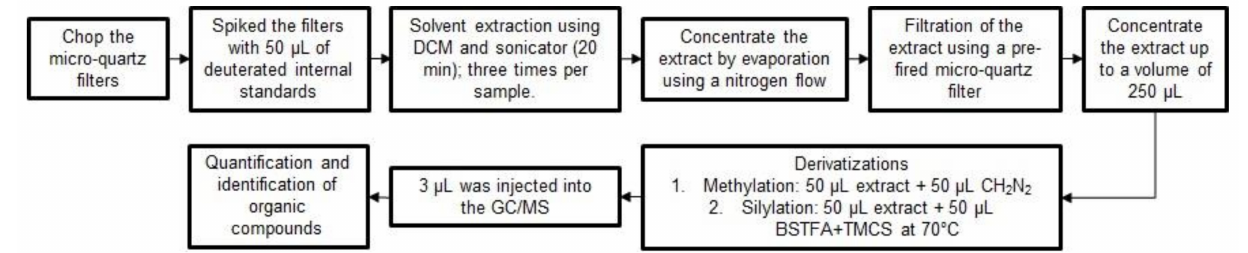
Figure 3. General methodology for conducting the GC/MS analysis.